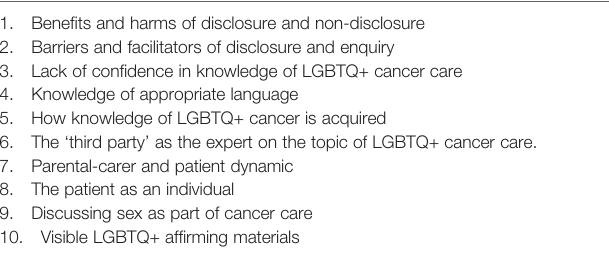
TABLE 1 | Themes identi fi ed through analysis of HCP